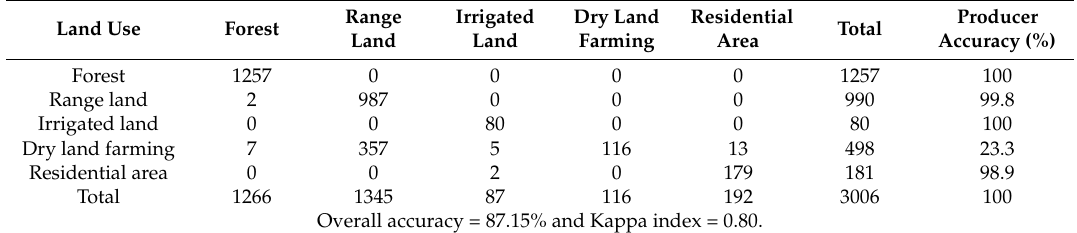
Table 4. Error matrix and accuracy assessment of the land use map for